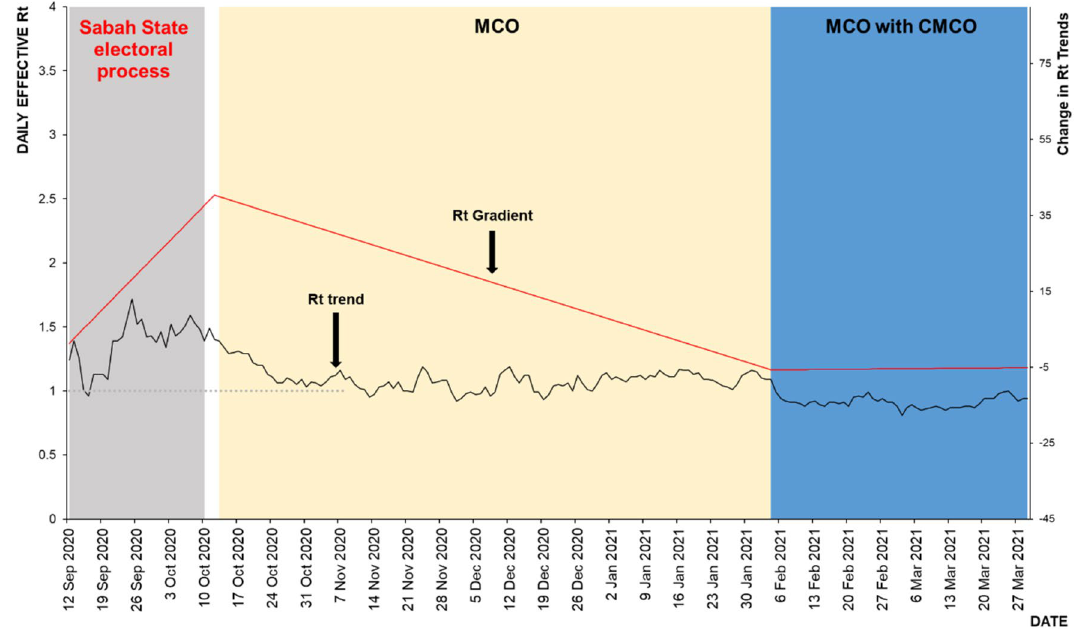
Figure 8. Estimated Rt for the propagation and control events, third wave of COVID-19, 12 September 2020 to 29 March 2021, Malaysia.